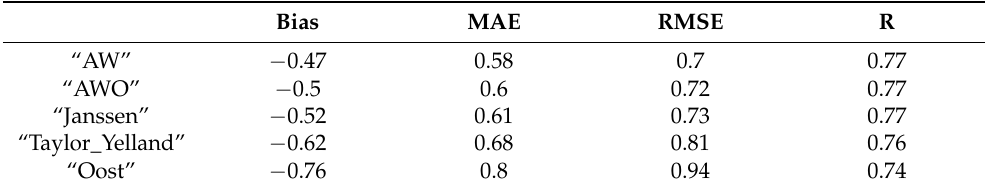
Table 3. Statistical characteristics of model errors in SWH (m) when compared with the altimeter data during the period 10–12 December 2006.